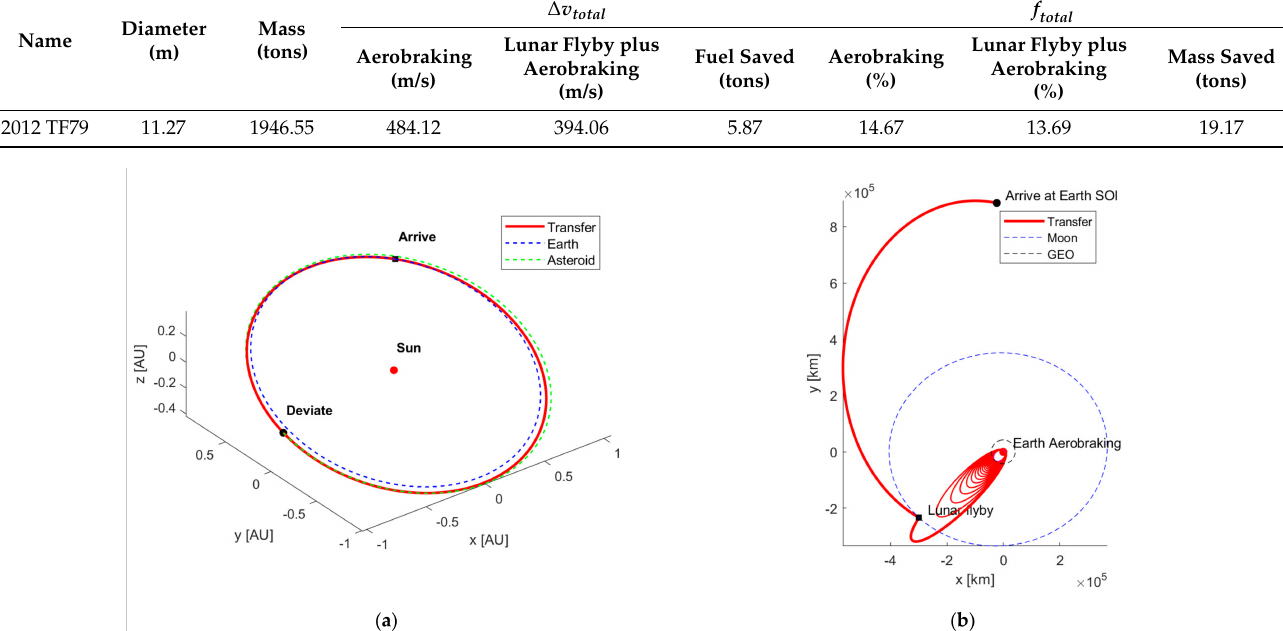
Figure 4. Asteroid 2012 TF79’s transfer trajectories; ( a ) the heliocentric transfer trajectory; ( b ) the geocentric transfer